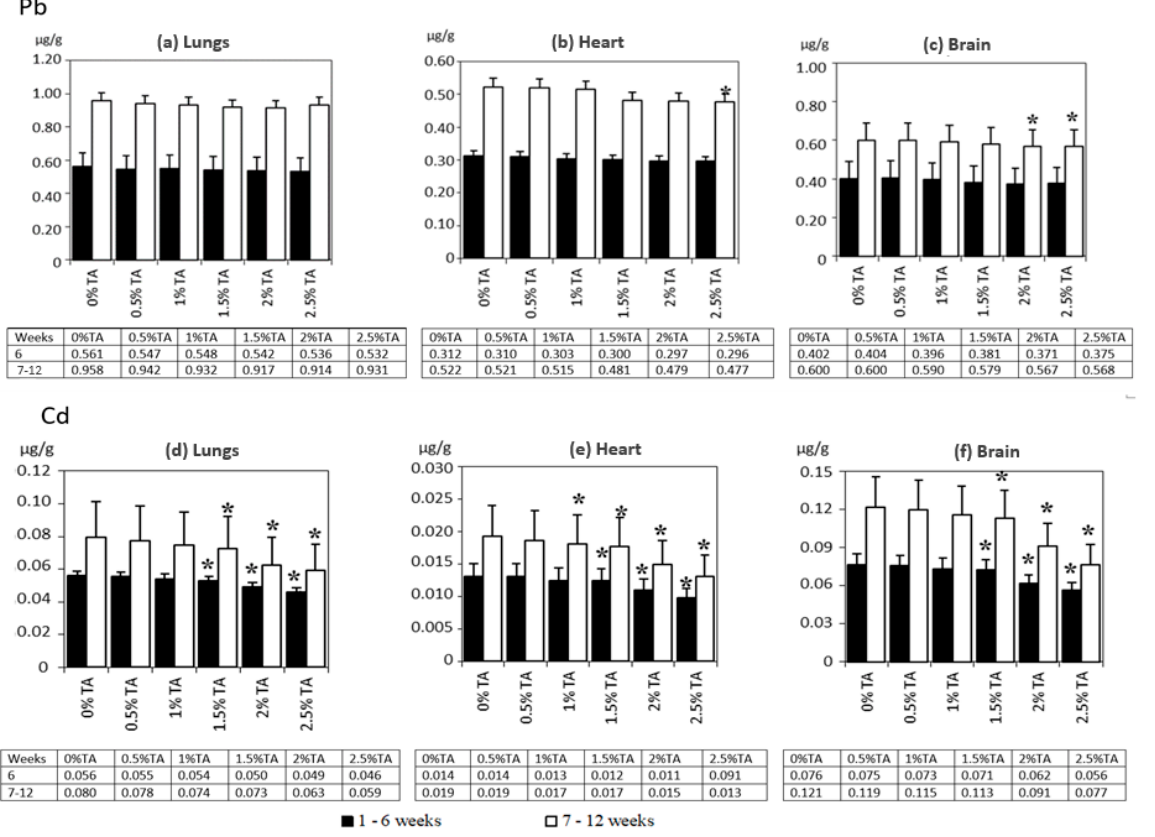
Figure 2. Experiment 1—The distribution of Pb and Cd in the lungs, heart and brain for 6 and 12 weeks of exposure (mean ± SD). SD—standard deviation; * significant ( p < 0.05) versus 0%TA